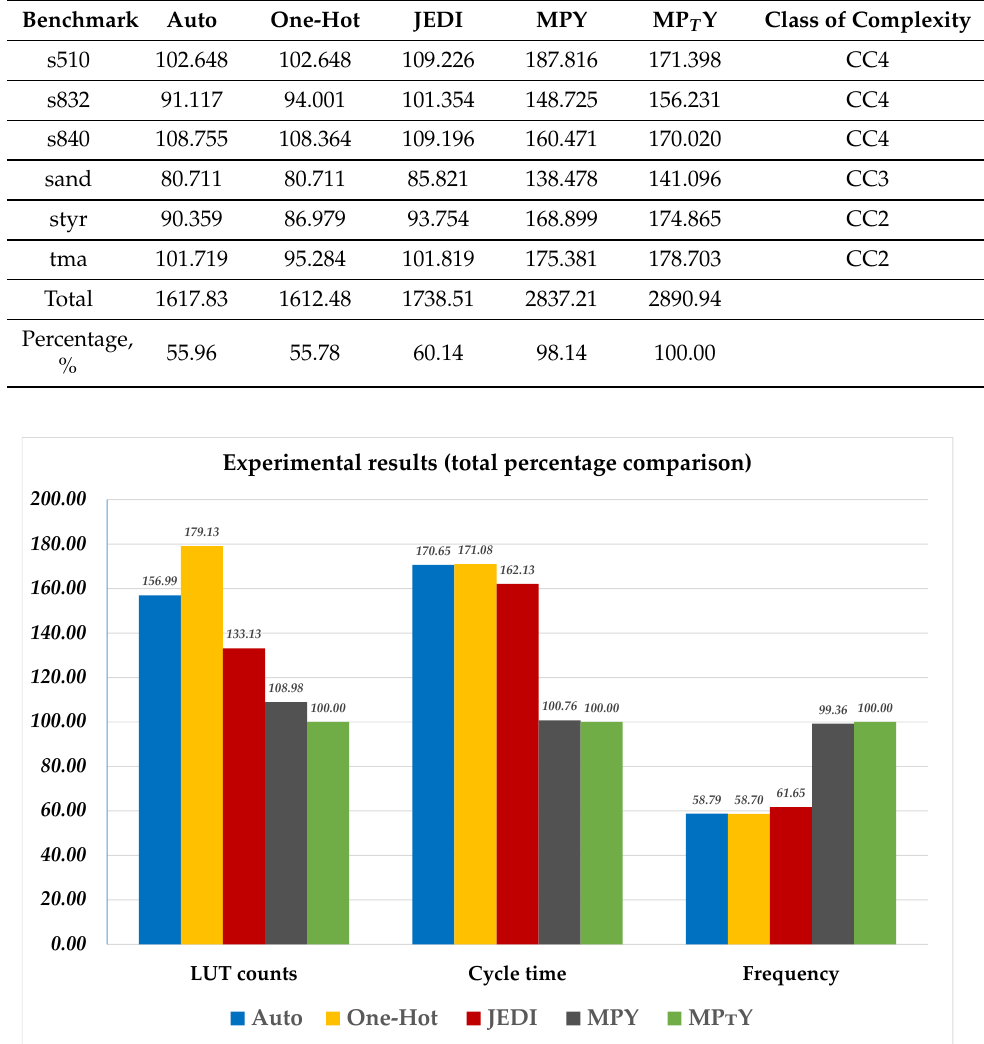
Figure 9. Comparison of percentages for the main characteristics of the studied